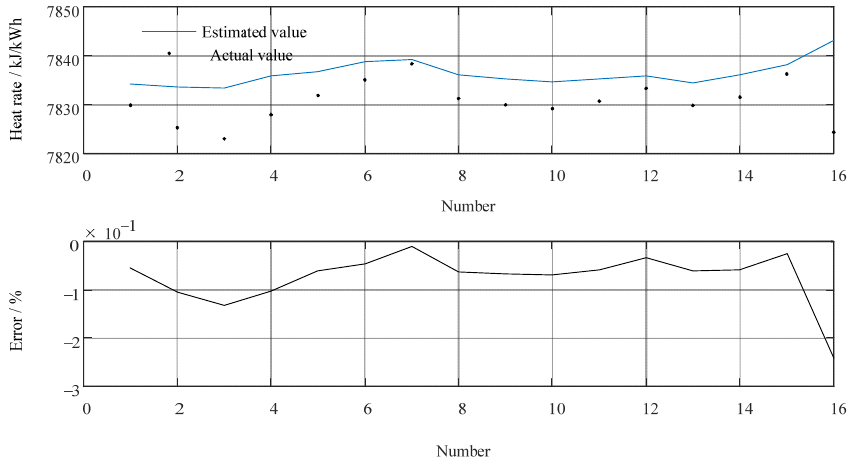
Figure 8. The model test results of the heat rate index. Moreover, the MSET model established by partial data in cluster #1 is utilized to test the rule between the change in unit operation level and the estimation accuracy. The data from cluster #1, cluster #2, cluster #3 and cluster #4 are taken as test data. Error percentage values are then calculated by parameters as main steam temperature, main